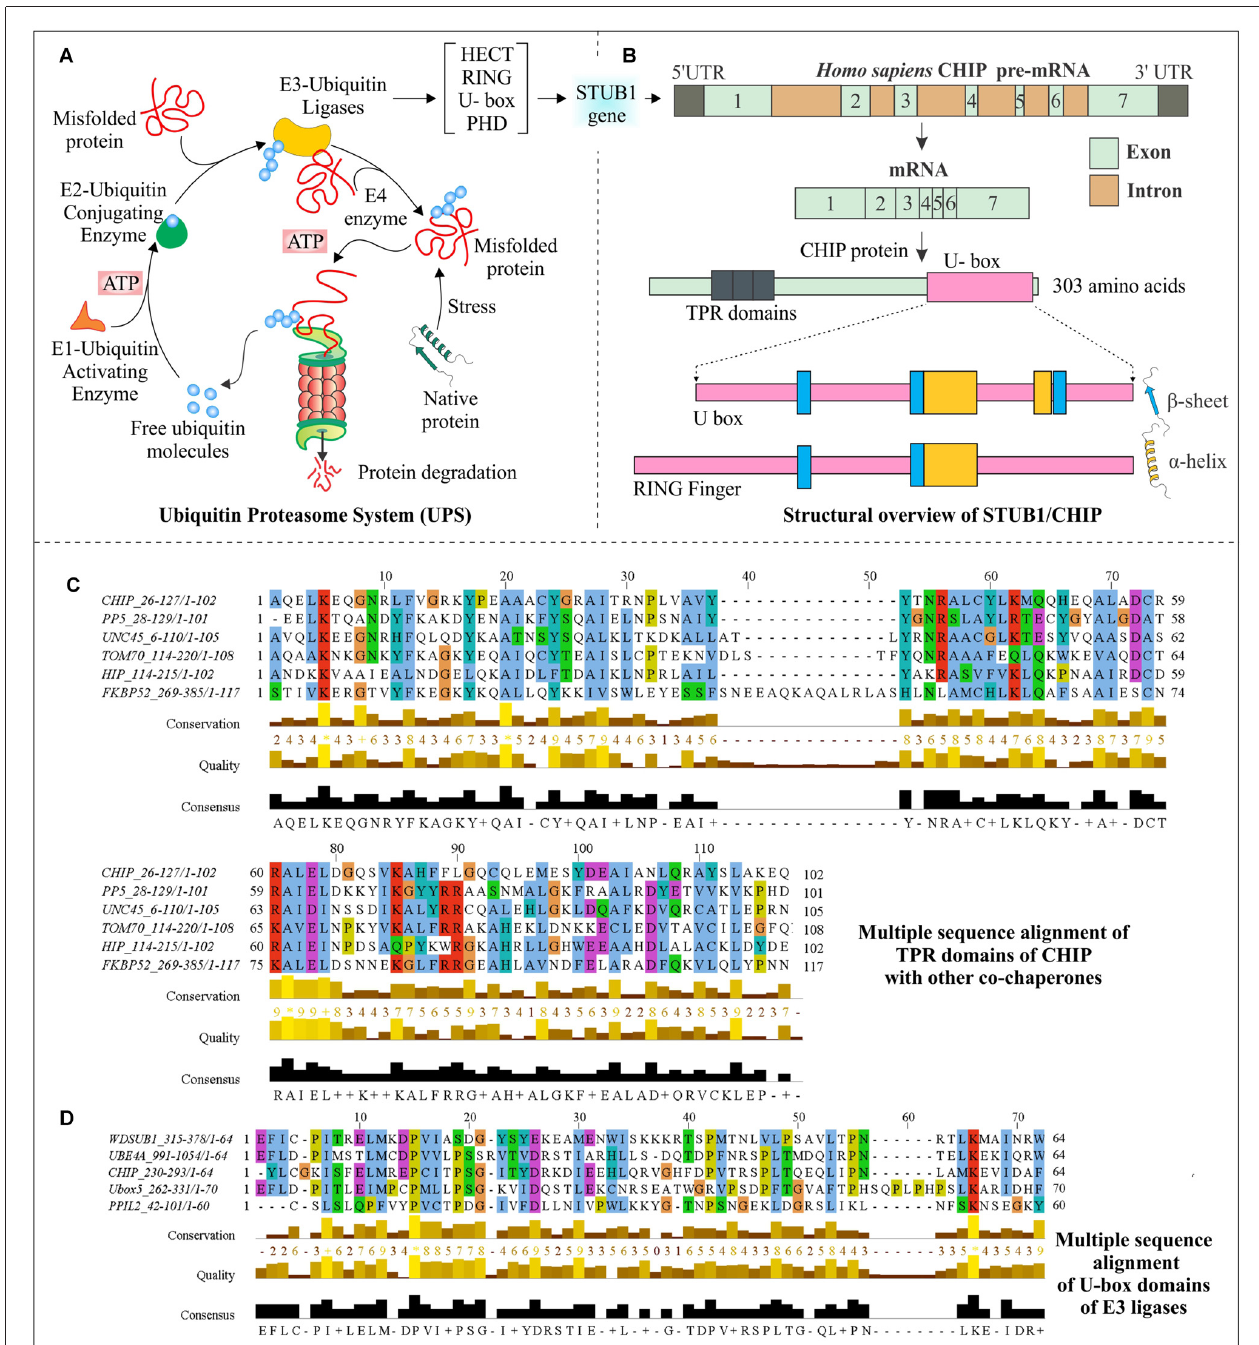
FIGURE 1 | Structural aspects of C-terminus of Hsc70-interacting protein (CHIP) and multiple sequence analysis of its domains. (A) Schematic representation of the ubiquitin proteasome system (UPS) shows an ATP-dependent ubiquitin activation by E1 ubiquitin activating the enzyme, followed by attachment of ubiquitin to E2 conjugating enzymes and later targeting misfolded proteins by specific E3 ubiquitin ligase enzymes for degradation by 26S proteasome complex. (B) Human STIP1 Homology And U-Box Containing Gene 1 (STUB1) gene codes for E3 ubiquitin ligase CHIP; mRNA contains seven exons and six introns. The mRNA synthesizes a 303 amino acid long protein, which contains three tetratricopeptide repeat (TPR) domains at its N-terminal and one U-box domain at its C-terminals. A structural comparison of U-box domain with RING finger domain has been done to illustrate the respective arrangements of α -helices and β -sheets. (C) Sequence alignment of CHIP with other co-chaperones, showing evolutionarily conserved TPR domains. (D) U-box domains of CHIP and different E3 ubiquitin ligases have been aligned to elucidate their conserved region. Clustal Omega and Jalview were used for alignment and visualization respectively, with default coloring schemes (Clamp et al., 2004; Sievers et al., 2011). Asterisk ( ∗ ) shows absolute conservation of amino acids, whereas score 0–9 followed by plus sign shows the levels of amino acid conservation.